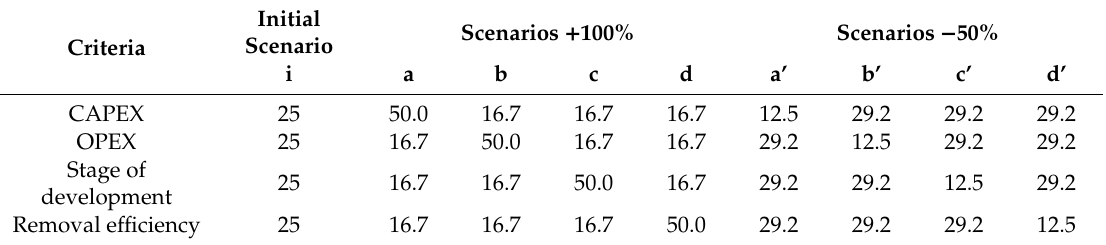
Table 4. Given to criteria selected to run the case-study validation ( i ) and the sensitivity analysis ( a – d’ ).